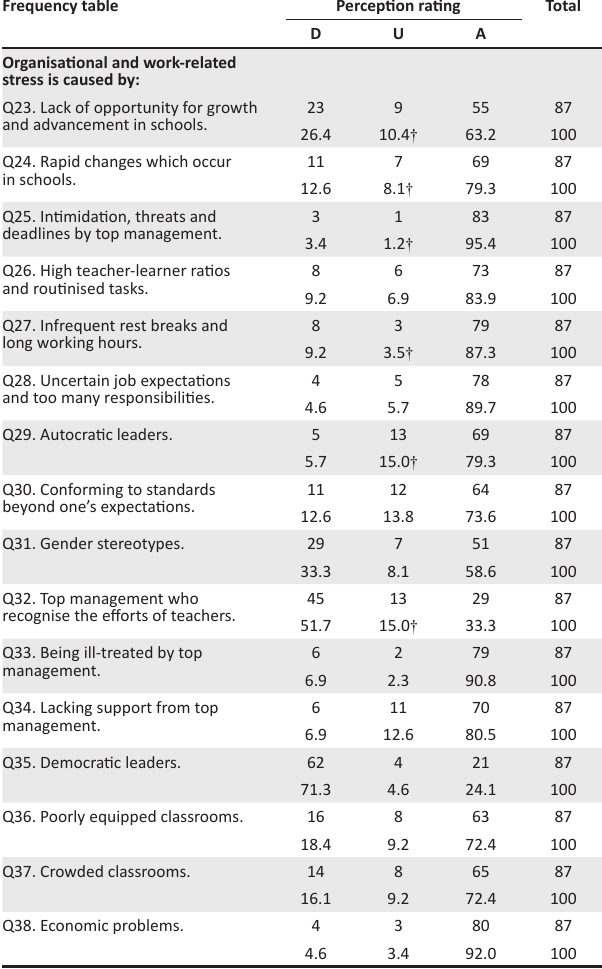
TABLE 3: Causes of organisational and work-related stress ( n = 87). Frequency table Perception rating